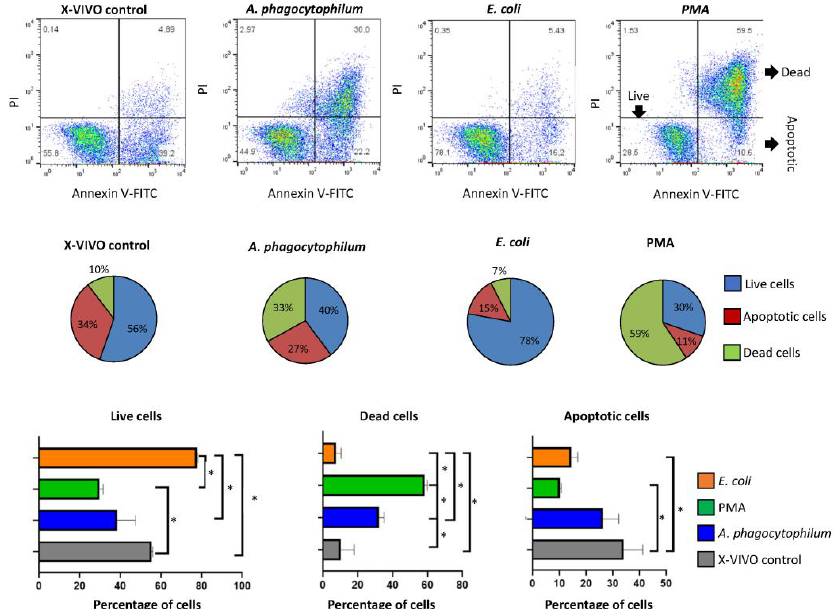
Figure 2. Cellular viability and apoptosis study after different treatments by flow cytometry.